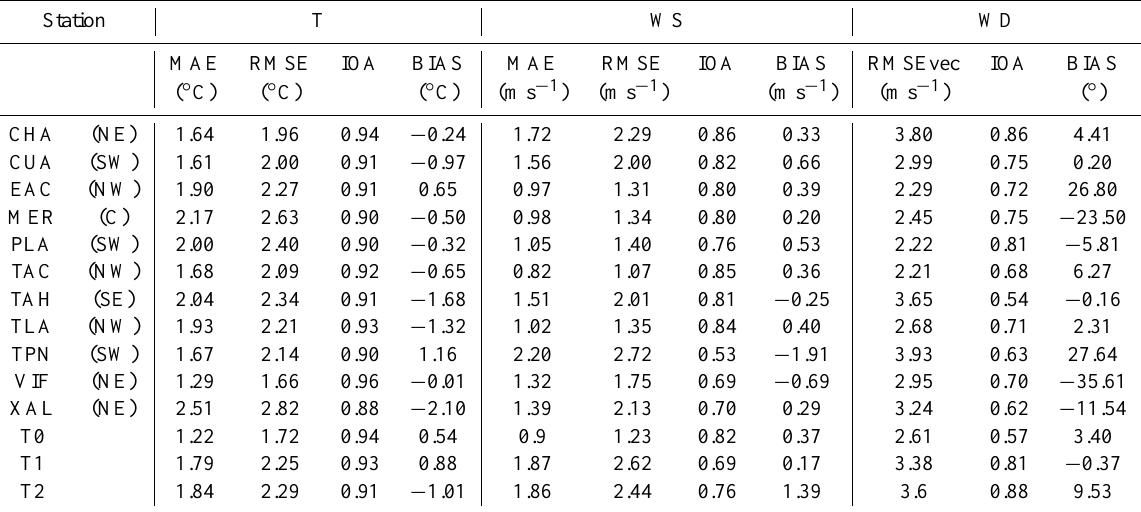
Table 3. Performance statistics of the surface variables in the third simulation domain. Location with respect to the center of the city is in front the station